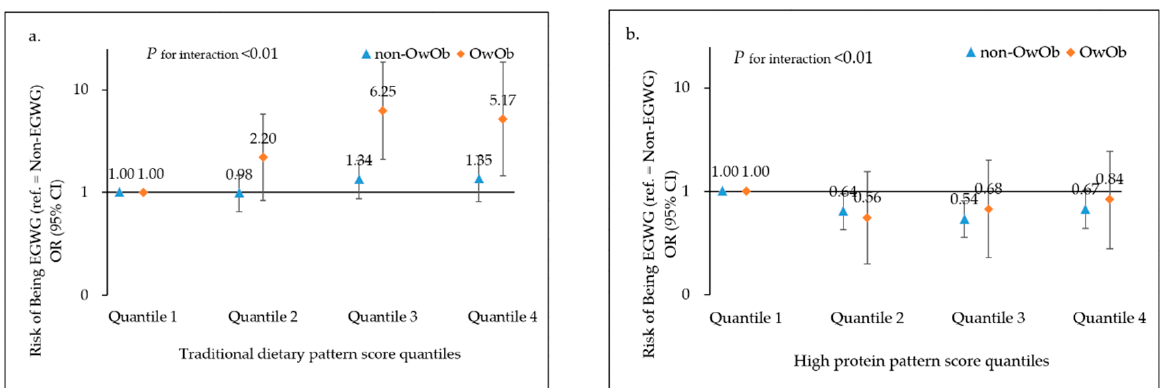
Figure 1. Associations between ( a ) traditional dietary pattern, ( b ) high protein dietary pattern score quantiles with risk of EGWG, stratified by pre-pregnancy weight (non-OwOb vs. OwOb). Adjusted for other dietary pattern scores, age, parity, family income, education level, ethnicity, smoking status, total energy intake per day, and physical activity per week. EGWG: excess gestational weight gain; OR: odd ratio; CI: confidence interval.